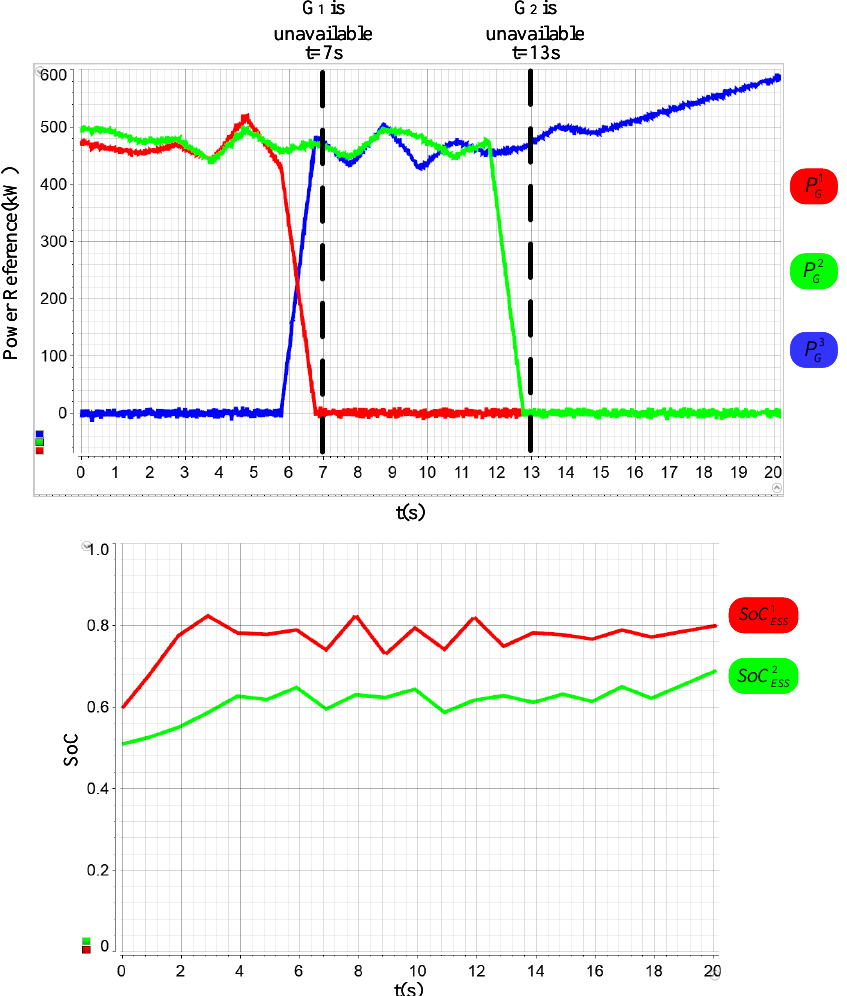
Figure 13. The proposed method obtains online energy management